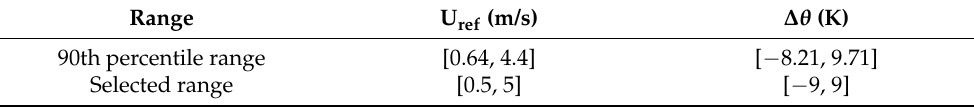
Table 2. Range of U ref and ∆ θ